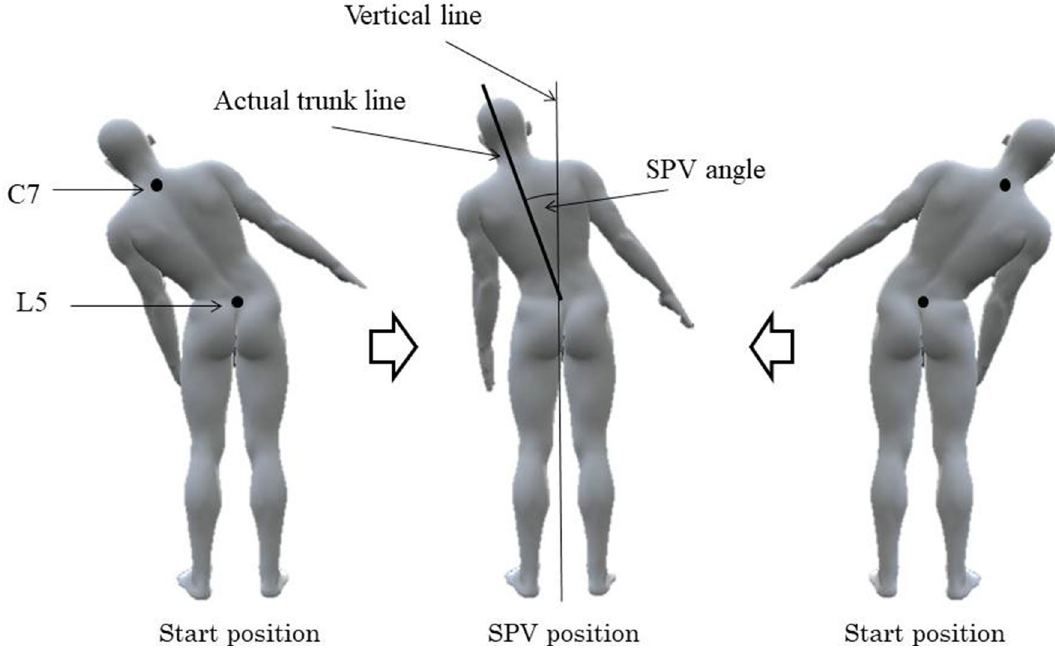
Figure 4. Evaluation of the SPV angle. SPV subjective postural vertical, C7 seventh cervical vertebra, L5 fifth lumbar